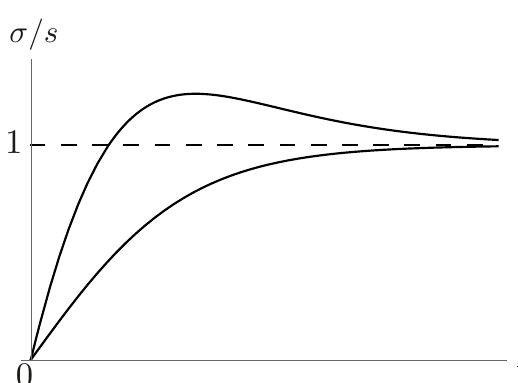
Figure 1. For a CFT excited state in which the FLEE applies and s 6 = 0, we schematically depict the two simplest possibile behaviors of (cid:27) , in units of s , versus L , in arbitrary units. The FLEE implies (cid:27) / L at small L . As L ! 1 , either (cid:27) ! s (cid:0) (lower curve), consistent with the area theorem, or (cid:27) ! s + (upper curve), violating the area theorem. The latter case necessarily has at least one maximum, as